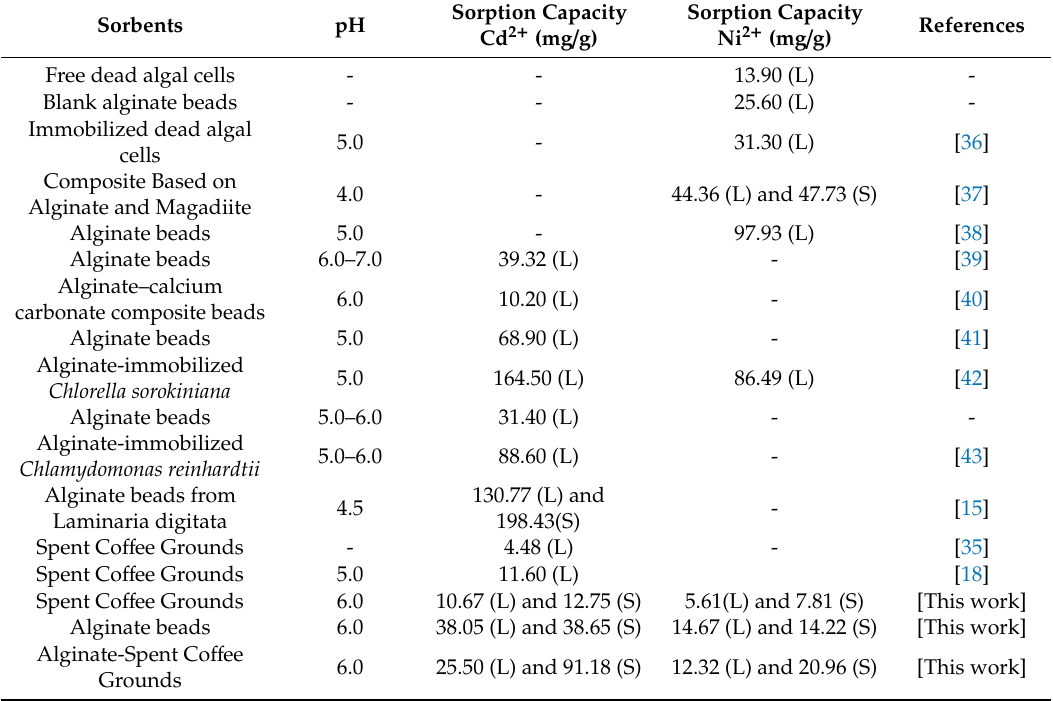
Table 4. Maximum adsorption capacities (mg / g) of di ff erent alginate, algal-based, or spent co ff ee adsorbents from Langmuir model (L) and Sips model